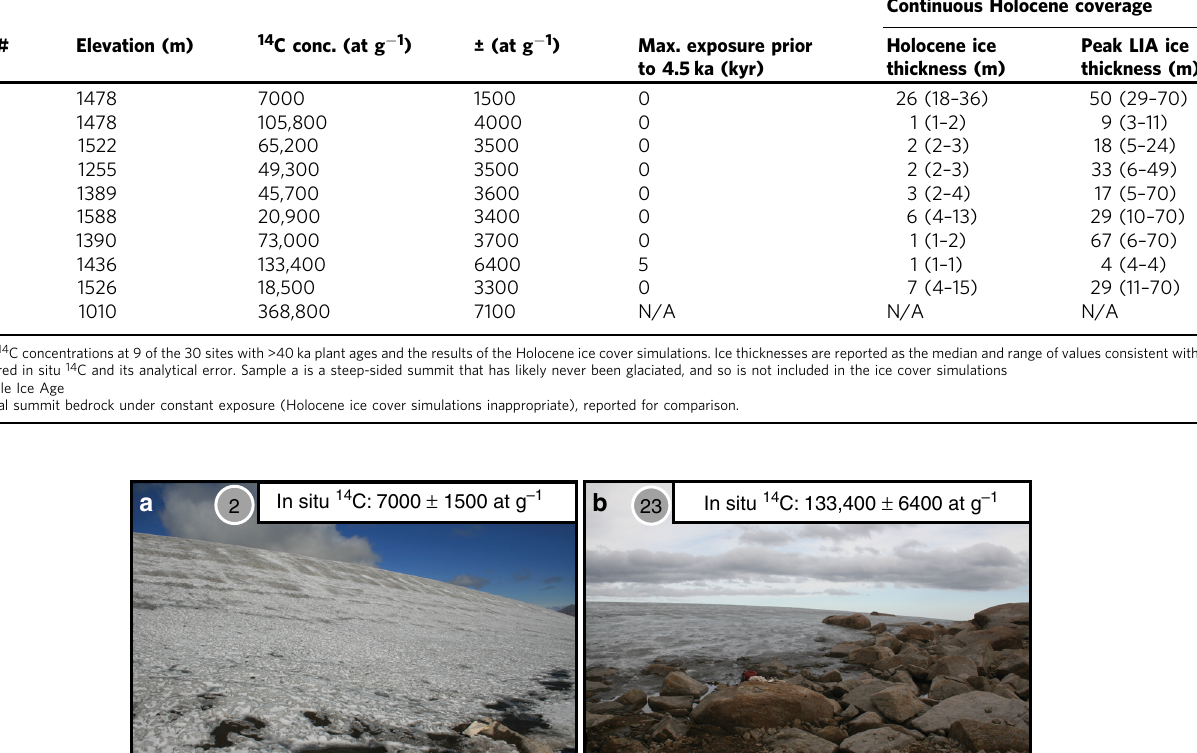
Continuous Holocene coverage